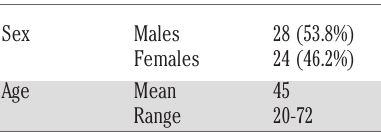
Table 2. Distribution of patients with aneurysmal SAH by artery of origin. Artery of origin Figure 1. DSA (AP) views of a 20 year old woman presenting with symptomatic vasospasm, showing severe vasospasm. The arrow indicates the coiled anterior communi- cating artery aneurysm. Although all treatment options were used, she continued to decline until